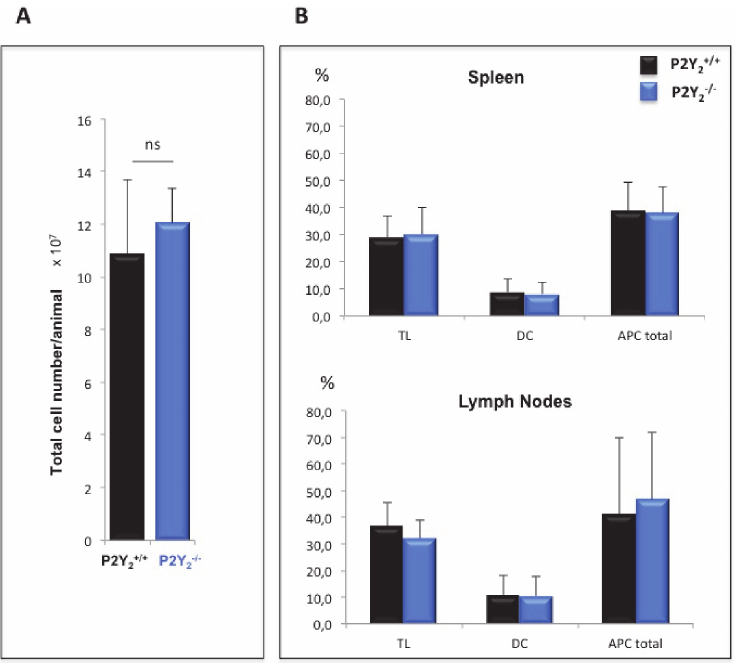
Fig 4. No difference in cell number or in cell phenotype between P2Y 2+/+ and P2Y 2-/- IRBP-immunized mice. Twelve days after s.c. immunization with IRBP 1 – 20 peptide emulsified in CFA and combined with an i.p. injection of PTX, P2Y 2+/+ and P2Y 2-/- mice were sacrificed and their spleen and draining lymph nodes collected and dissociated. (A) Total cell number count of mixture of splenic T lymphocytes semi-purified by passage on nylon wool fiber columns and LN cells. Mean +/- SEM. (B) Spleens and LN were independently characterized by flow cytometry for cellular phenotype by using FITC- or PE- anti-mouse antibodies directed against CD3, CD11b, CD11c and MHCII surface molecules. TL: CD3+; DC: CD11c+/CD11b+ or MHCII+; APC tot: DC + CD11c-/CD11b+ or MHCII+. Mean +/- SEM. Data are from at least 10 different mice in each